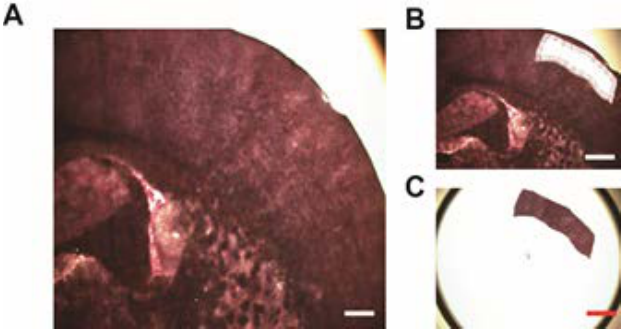
Figure 2. Sample collection by laser capture microdissection (LCM). ( A ) Infarcted tissue in the cerebral cortex before LCM. Scale bar: 0.5 mm; ( B ) Infarcted tissue in the cerebral